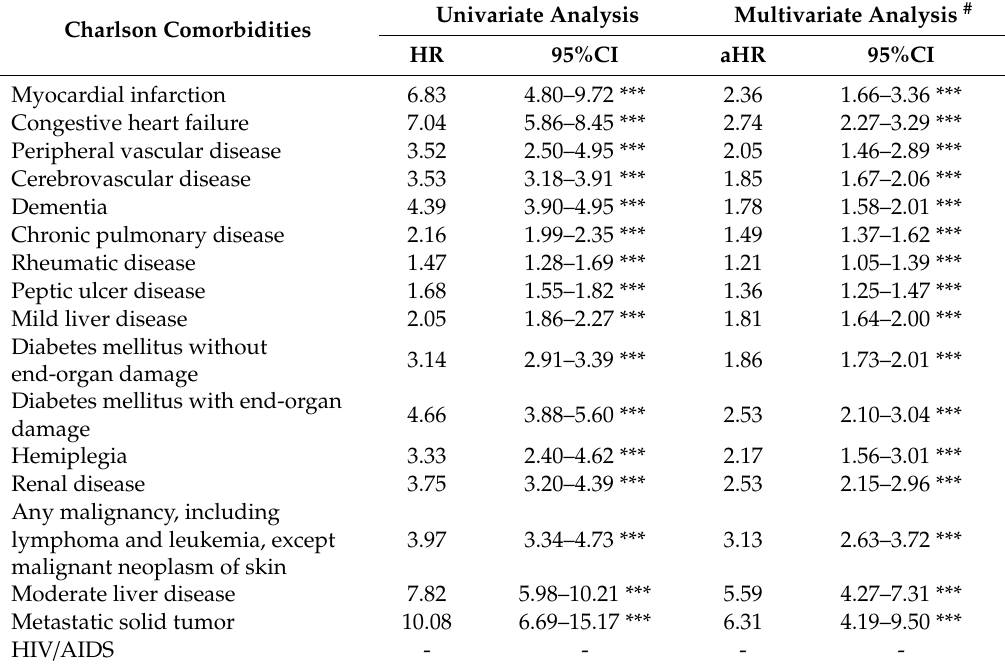
Table 4. Adjusted Hazard Rations of Mortality among Patients with Schizophrenic Disorders Based on the Charlson